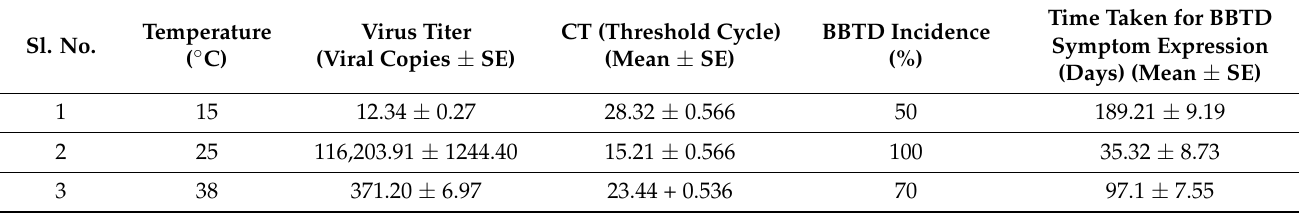
Sl. No. Table 3. Absolute quantification of BBTV titer in aphids through the SYBR Green-based qPCR assay for various temperature treatments. SE denotes standard error.